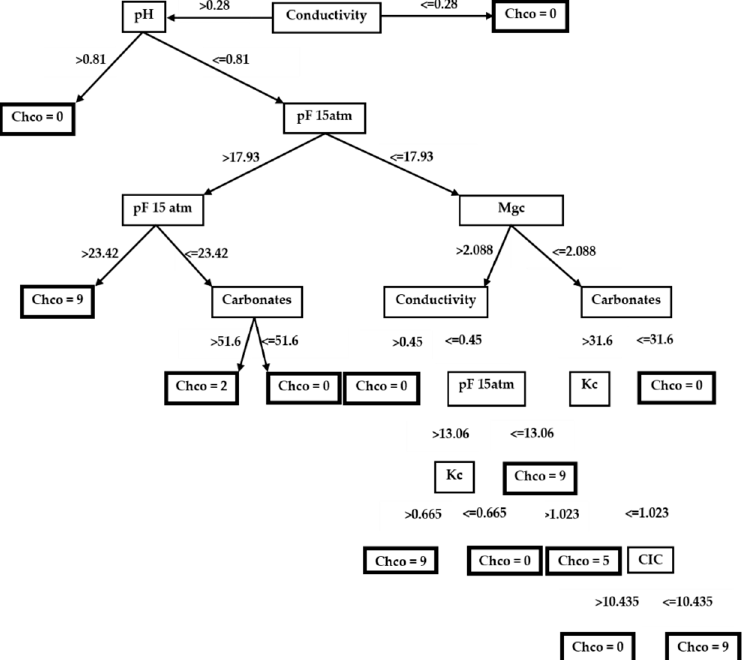
Figure 6. Decision tree for Chco = Glebionis discolor (= Chrysanthemum coronarium var. discolor ). The numbering inside the boxes represents the abundance–dominance index converted to Van der Maarel [40]. The other numbering corresponds to the range of values of the edaphic attributes.